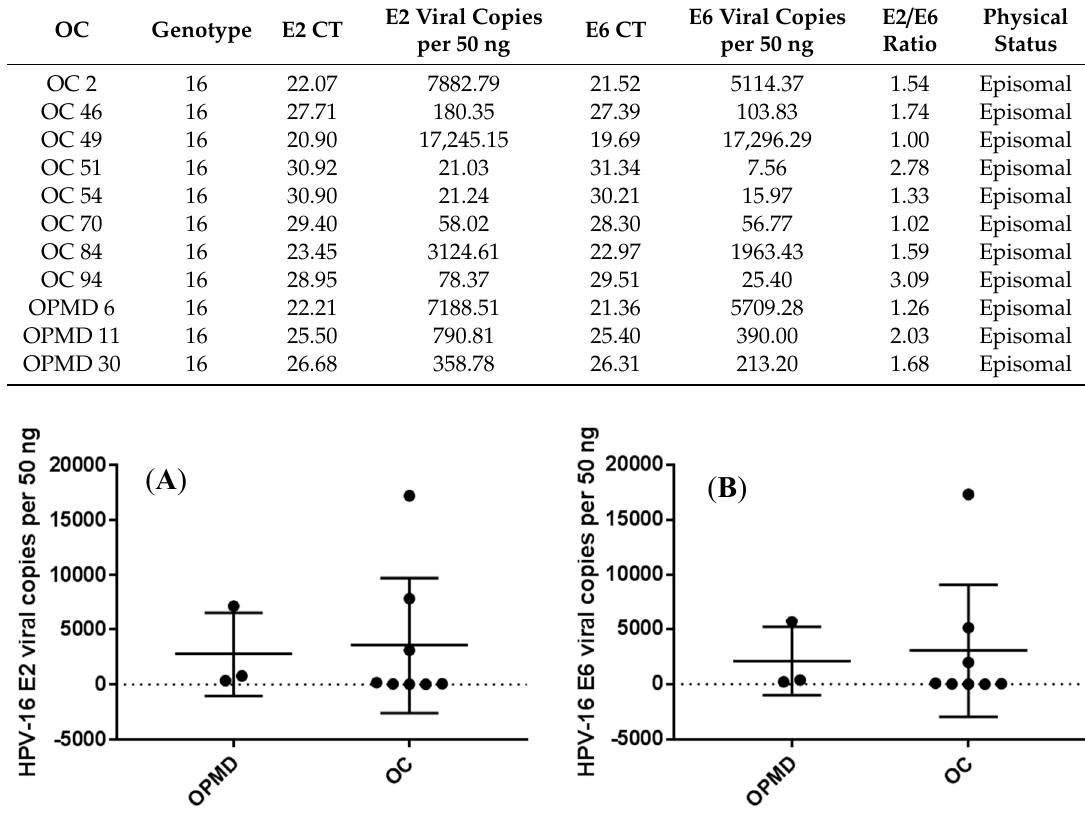
Figure 2. Salivary HPV16 E2 ( A ) and E6 ( B ) viral copies in OPMD and OC patients.